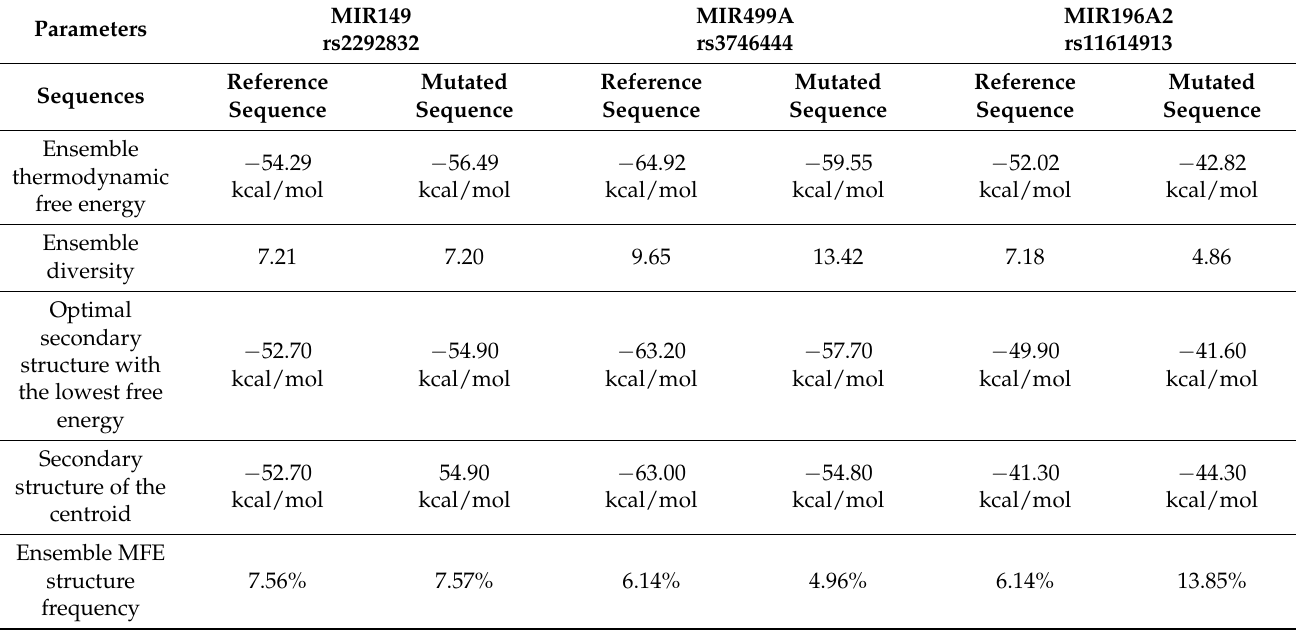
Table 4. Thermodynamic free energy differences between reference mutated